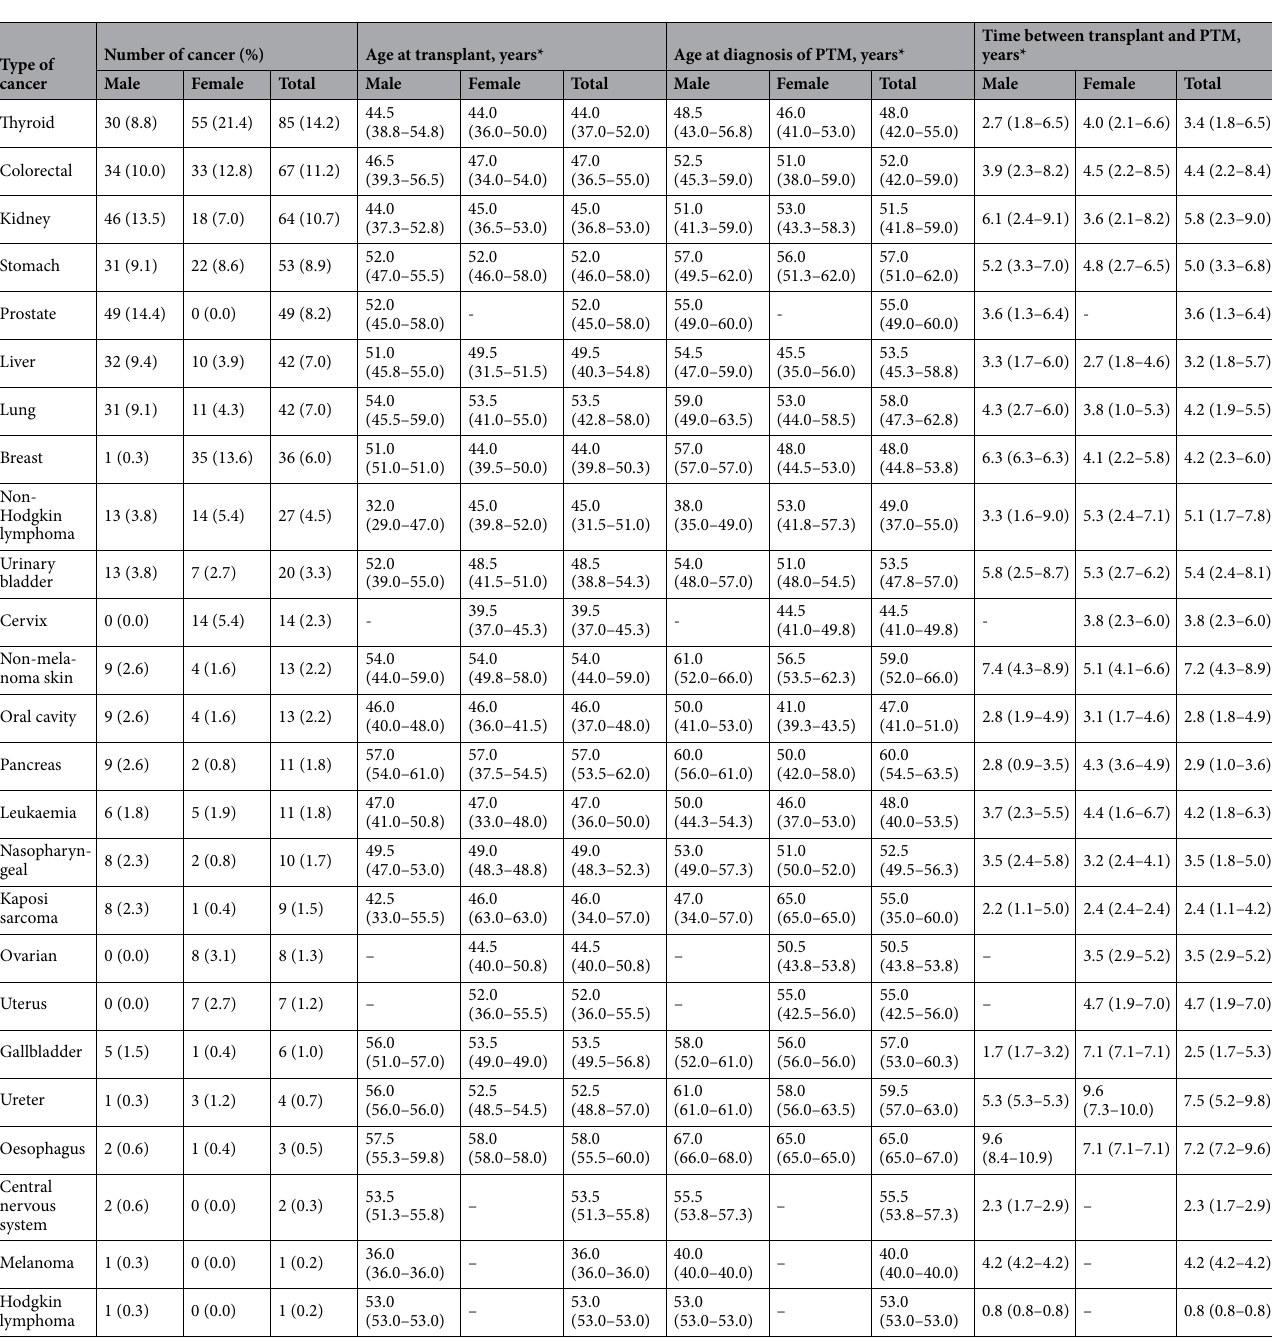
Table 2. Distribution of post-transplant malignancies. *Data are expressed as median and interquartile